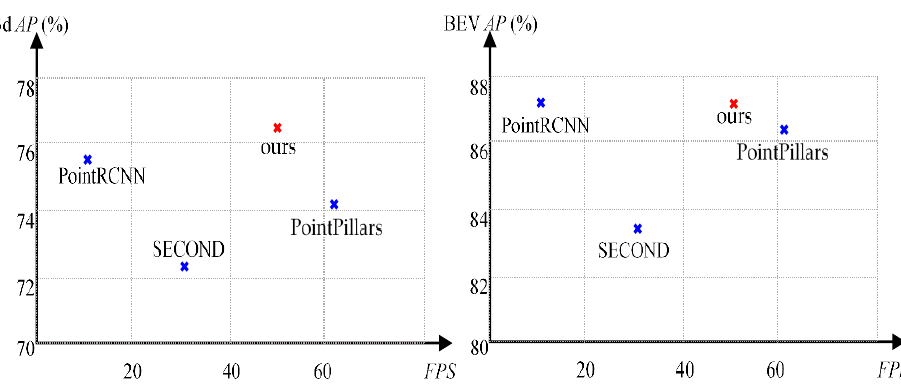
Figure 4. AP metric of car 3d and BEV detection in moderate level compared with some top-ranking approaches.